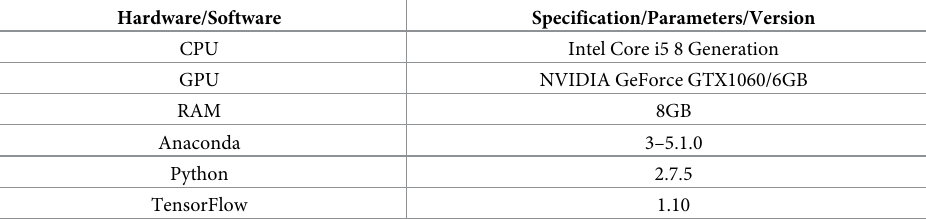
Table 2. Specific index parameters of the